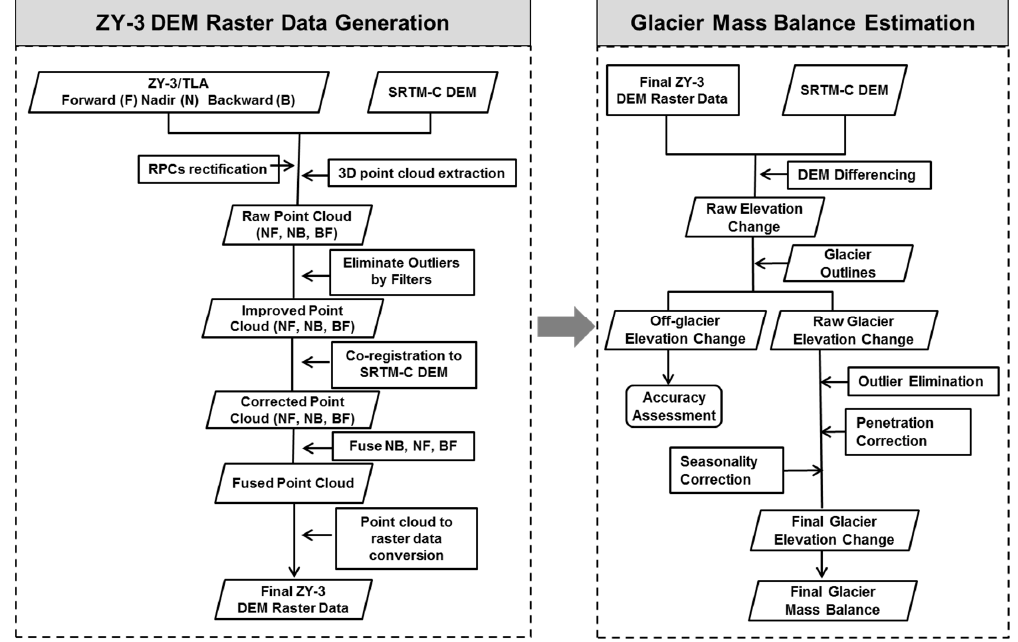
Figure 2. Workflow applied to generate the ZY-3 DEM and to estimate the glacier mass